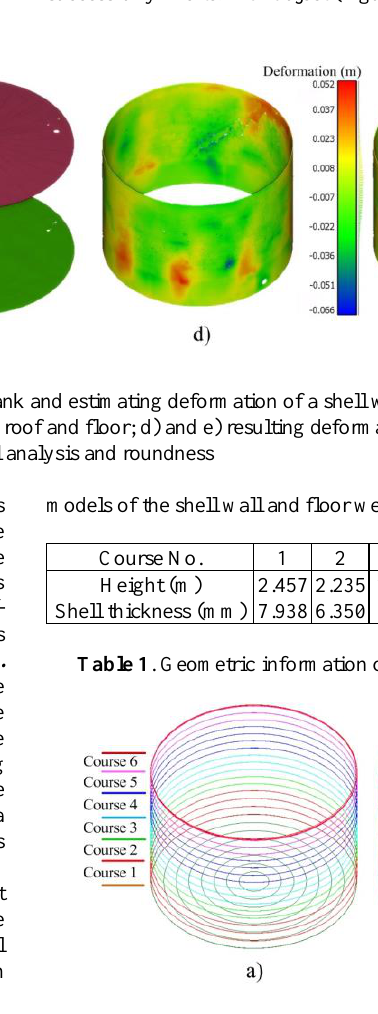
Figure 6 . Create a solid model of a tank (a shell wall and floor); a) fitting circles of cross-sections; b) 3D solid